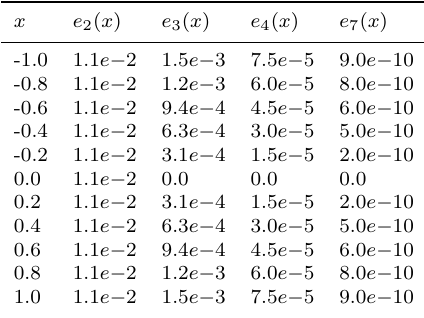
Table 5. Absolute error of Example